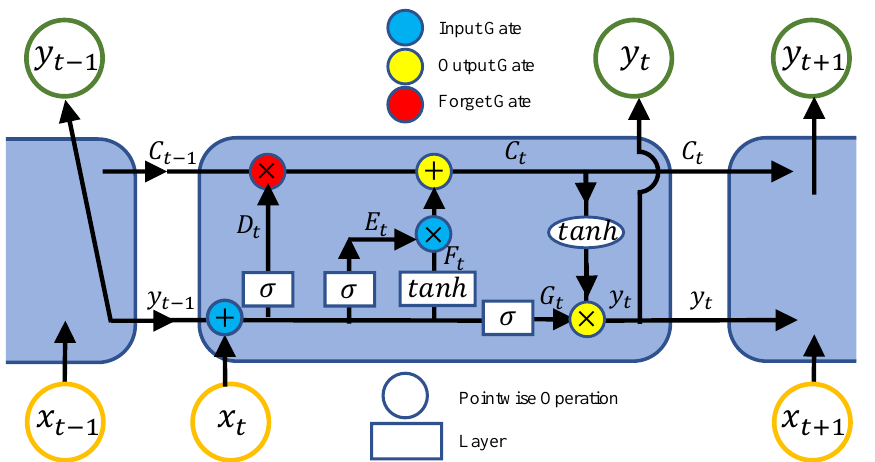
Figure 4. A schematic view of our deep learning scheme based on LSTM. Boxes and circles represent layers and pointwise operations, respectively. Blue circles are input gates and yellow circles are output gates. In addition, a forget gate shown by red circles is embedded, which allows the network to retain or forget some information. See text for the details of the algorithm. For example, the text σ means a sigmoid function and tanh means a tangent hyperbolic function, respectively, which are written in Equations